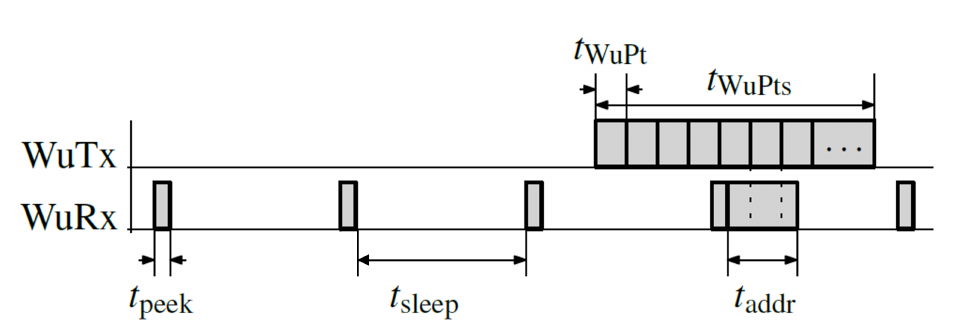
Figure 19. The timing diagram for duty-cycled wake-up communication based on